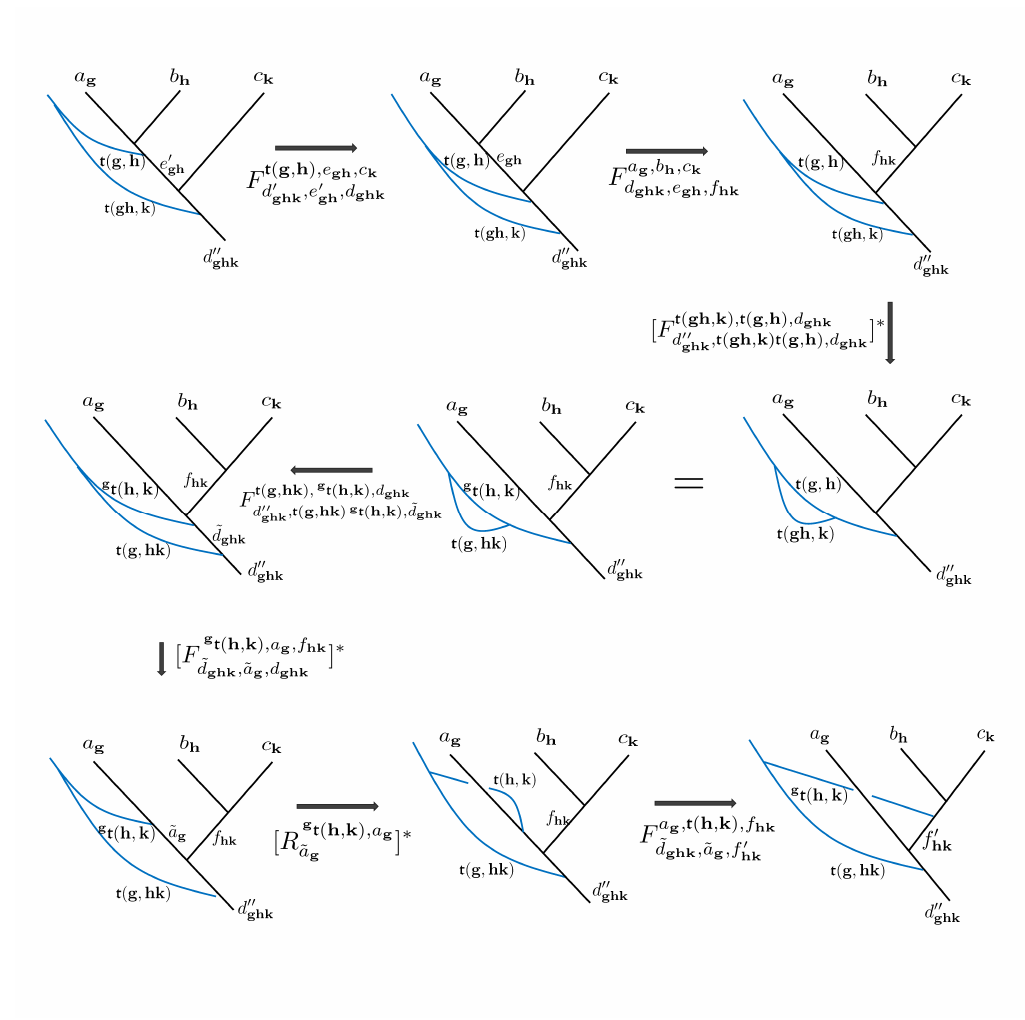
Figure 7: Sequence of moves in the original theory in order to determine the F sym- bols, ˜ F , for defects in the new theory. The defect fusion rules in the new theory are ( G , A ) relative to those of the original theory. We twisted by an element [ t ] 2 H 2 [ (cid:26) ] assume all defect and anyon lines have arrows pointing